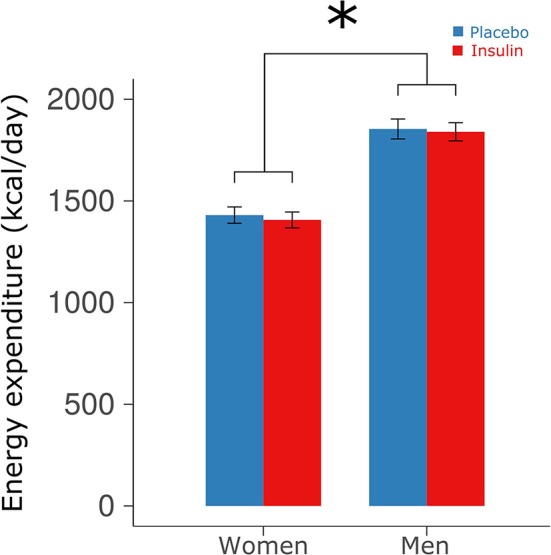
Energy expenditure. Mean ± SEM energy expenditure measured in the young participants via indirect calorimetry in the morning after intranasal administration of placebo (vehicle; blue bars) and insulin (160 IU; red bars) at 2220 h of the preceding evening. Calorimetry was performed in the fasted state at 0710 h before breakfast. *p < 0.05 for comparisons between sexes.